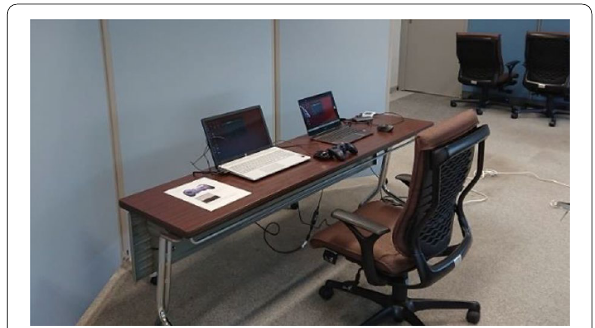
Fig. 9 Operator station for this experiment